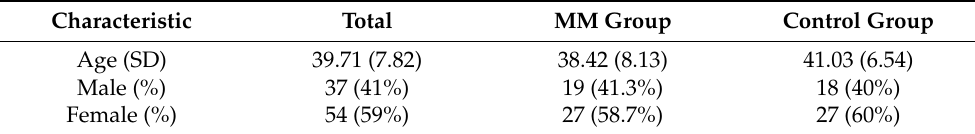
Table 1. Demographic characteristics of